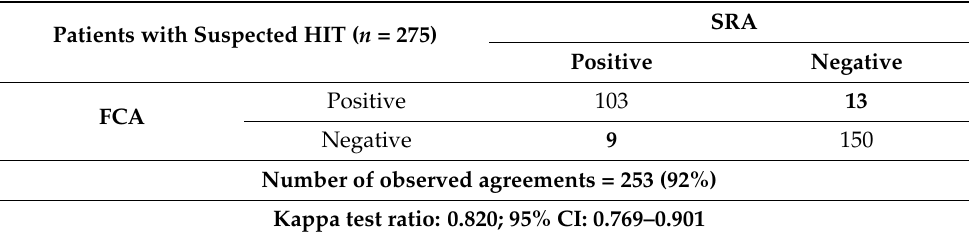
Table 4. Agreement between the FCA and SRA results evaluated by the Kappa test ratio. SRA indeterminate results were deleted for this analysis. Patients with Suspected HIT ( n =